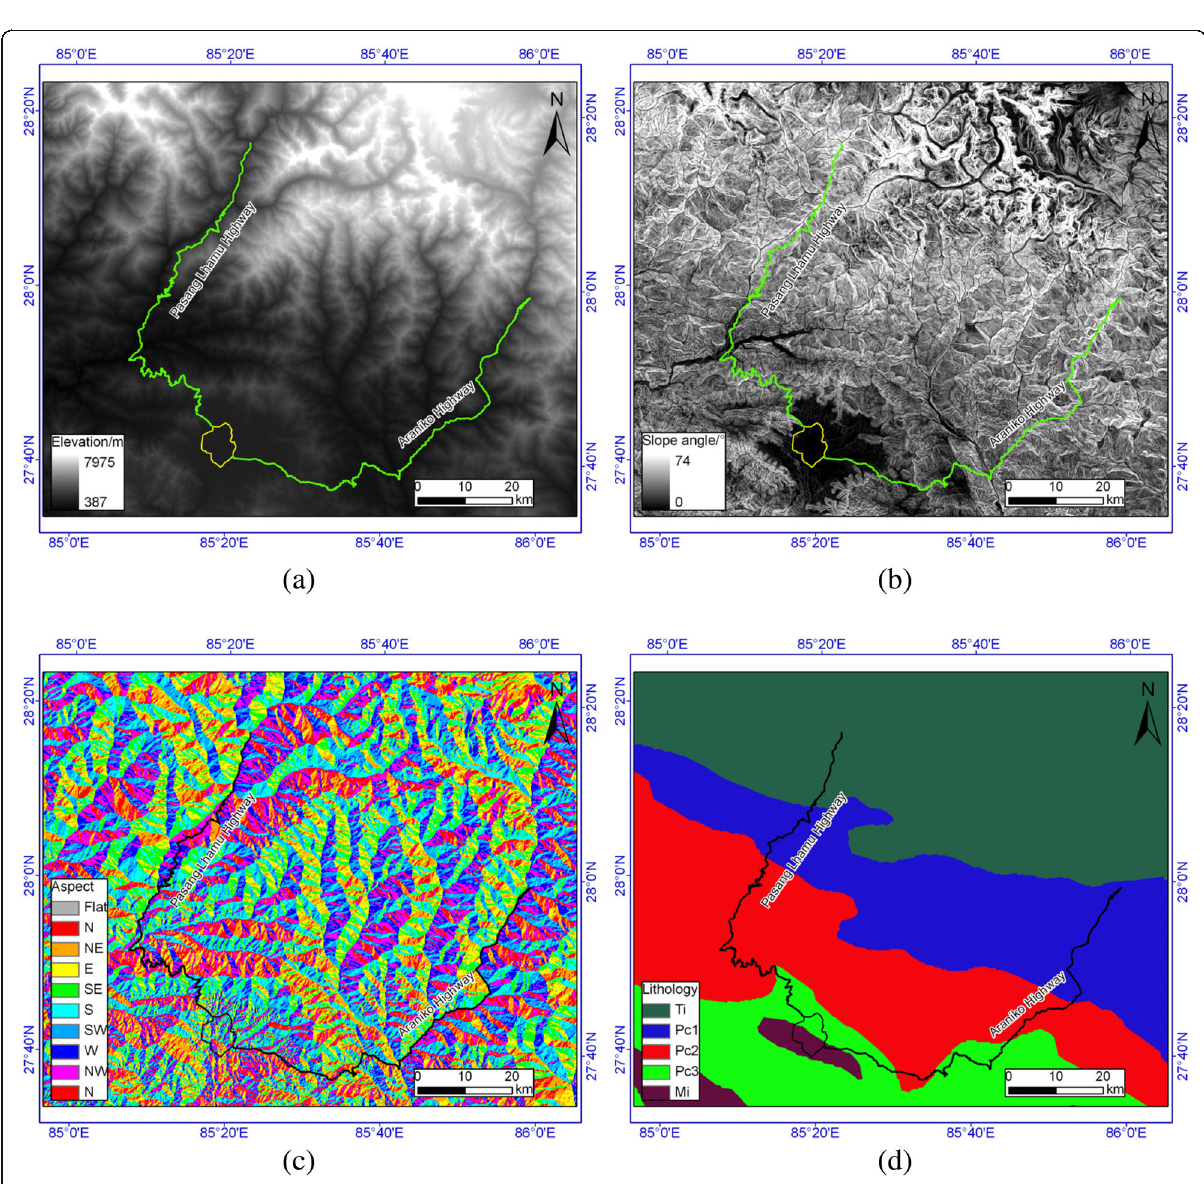
Fig. 2 Maps showing controlling factors of coseismic landslides of the study area. a Elevation. b Slope angle. c Aspect. d